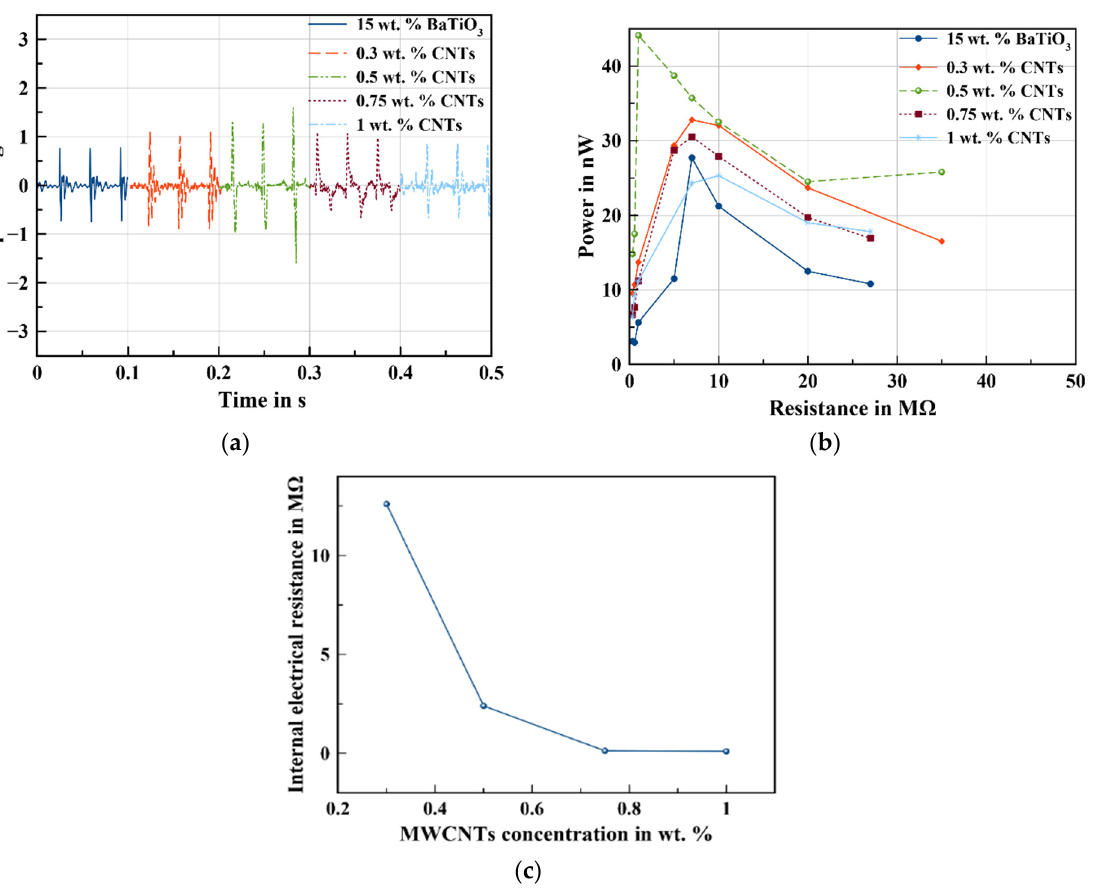
Figure 4. Effect of MWCNT concentration on the performance of the nanogenerators: ( a ) output voltage, ( b ) output power, and ( c ) internal electrical resistance.